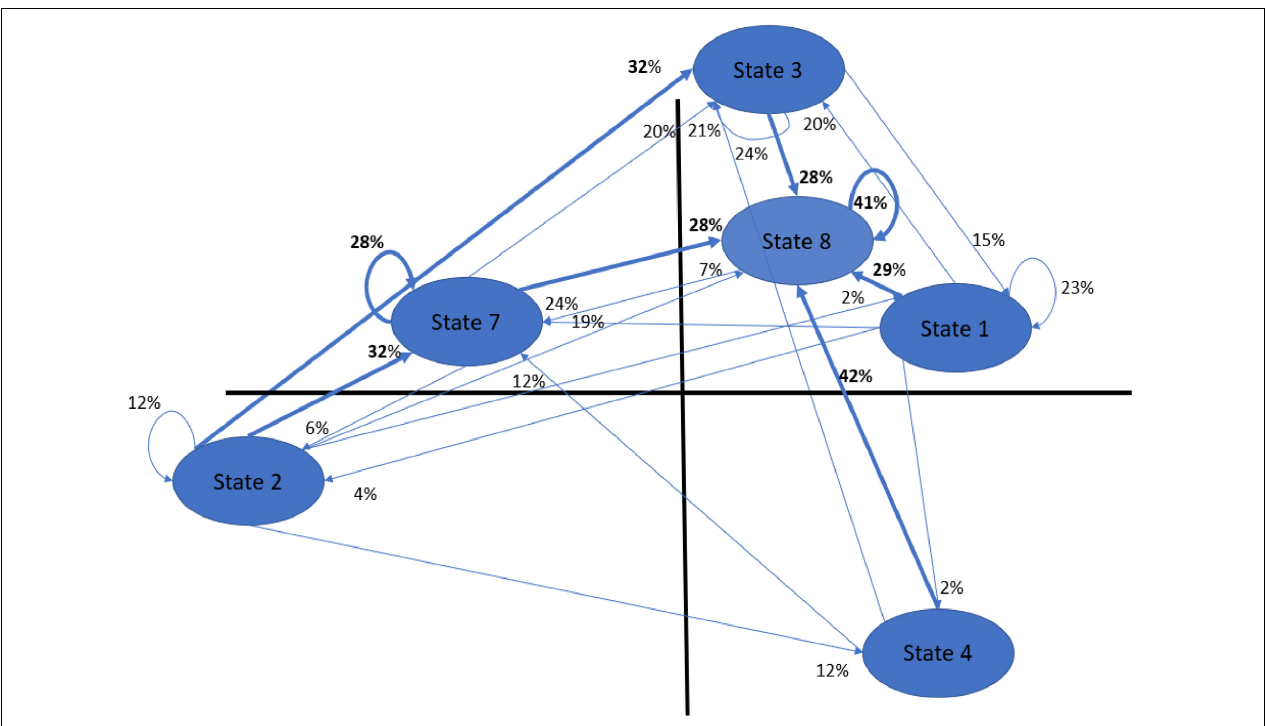
FIGURE 1 | Graphic visualization of George’s MTM or George’s linguistic network. Transitions with the highest occurrence for each state are in bold. In this case, we see a clear tendency to pass through state 8 (i.e., silence, the only state in which all three dictionaries show a minus sign), which is the most frequent state with 2191 occurrences (on a total of 7388). Second ranked was cluster 3 with 1494 occurrences, followed by cluster 7 (1484), and finally, cluster 1, cluster 4, and cluster 2, with 1115, 709, and 371, occurrences, respectively (see Appendix 2, Table III ). To interpret the profile of each state, see Appendix 2, Table II .